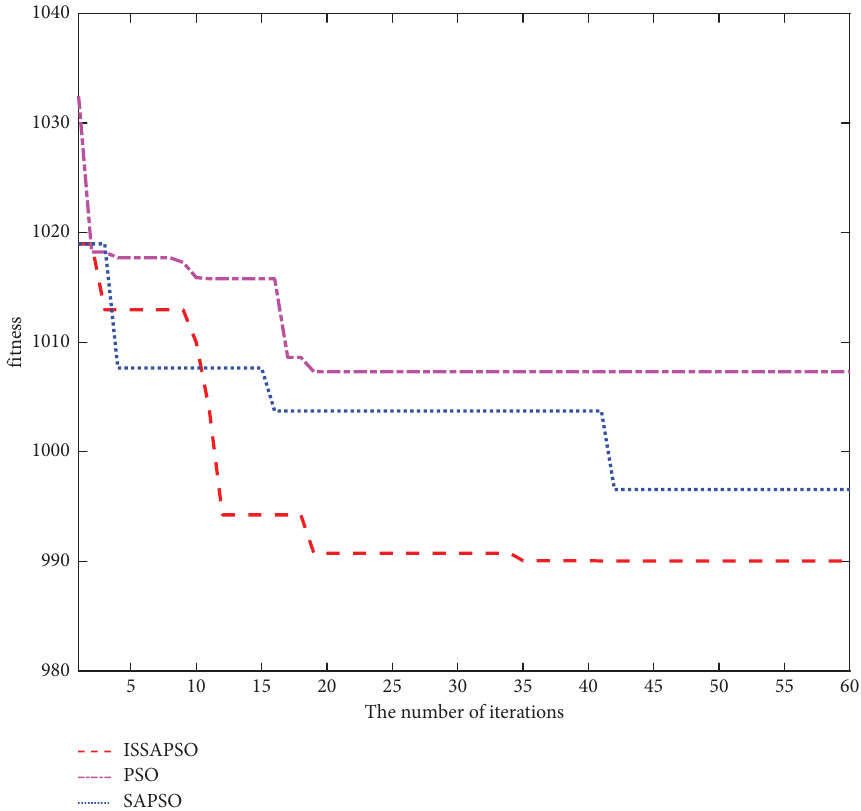
Figure 11: Comparison of algorithms implemented in the present